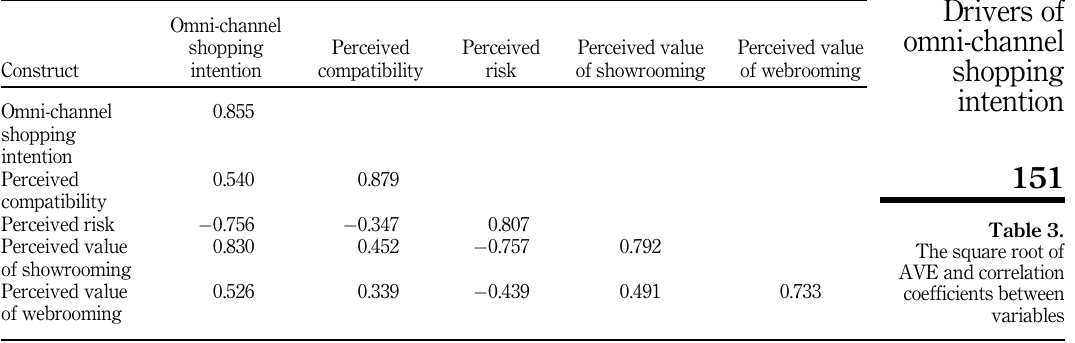
Table 3. The square root of